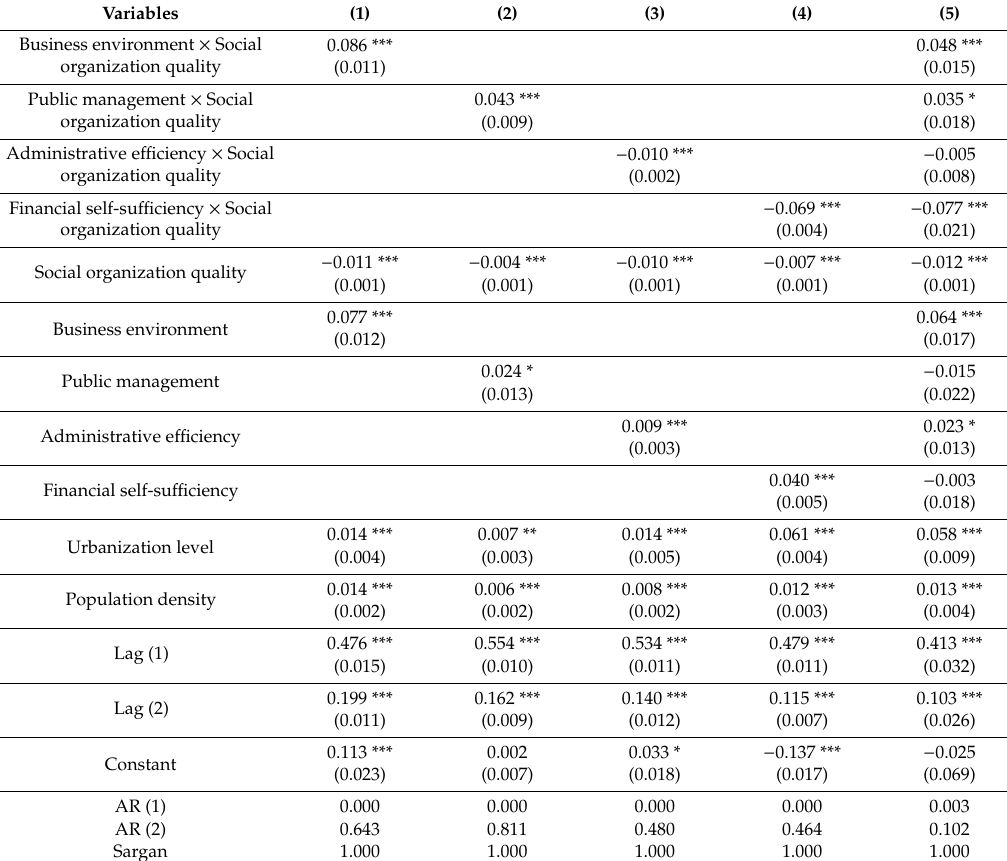
Table 8. Interaction between the government governance and social organization quality.